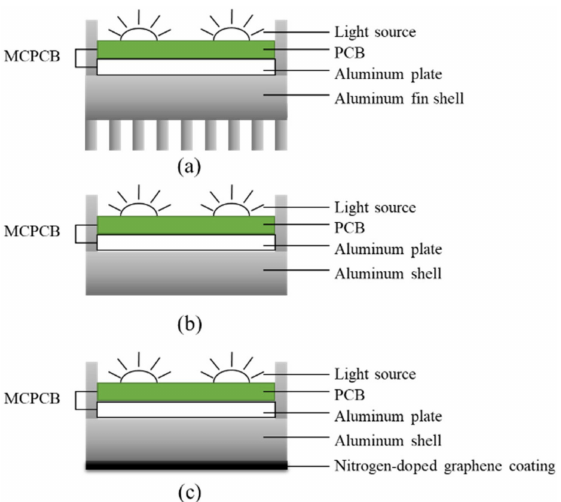
Figure 5. Layout of the monitoring points.